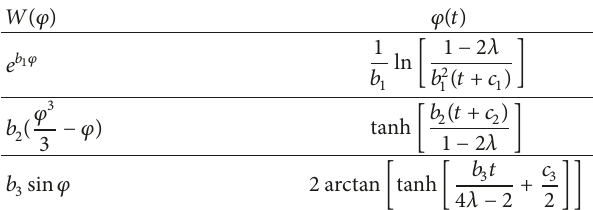
Table 1: Solution of ̇𝜑 = −𝑊 𝜑 /(1 − 2𝜆)